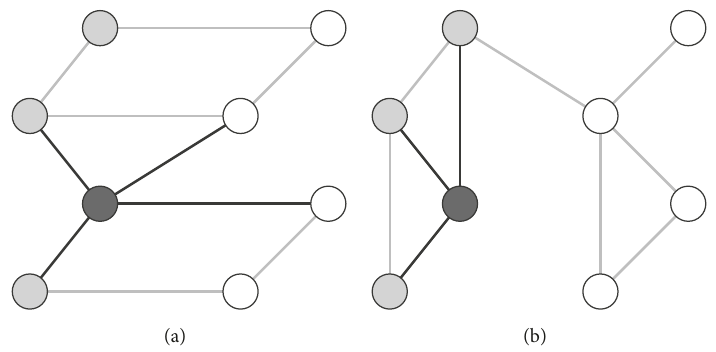
Figure 2: Possible influence relations of an